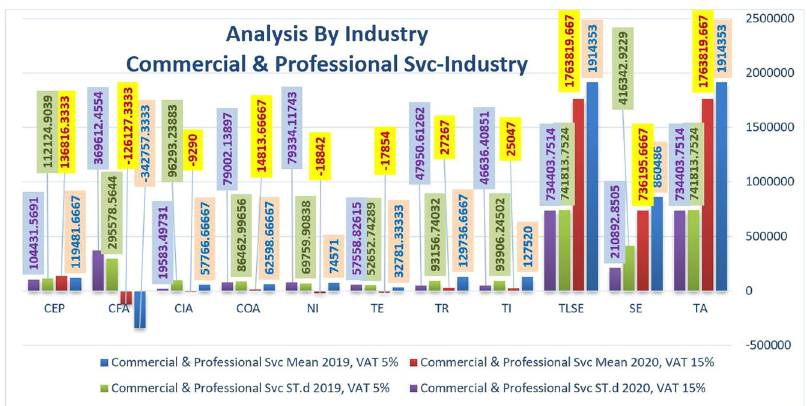
Fig. 6 Comparison of the fi nancial statements' key indicators in term of the average and standard deviation in Commercial & Professional Svc industry before and after rising